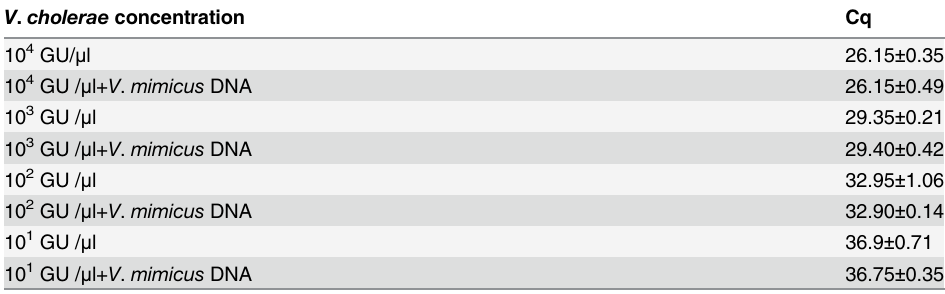
Table 1. qPCR detection of V . cholerae ATCC 39315 cells in mixed cultures containing V . mimicus UM